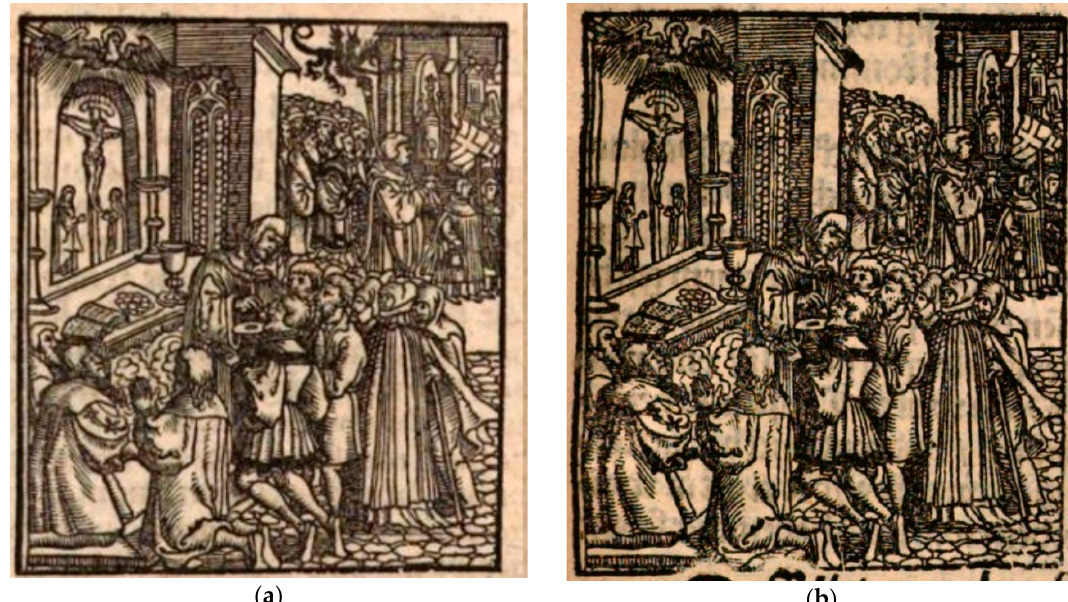
Figure 1. Communion and procession , woodcut recurring in books published by vom Berg and Neuber [S 22] (see Appendix A) ( a ) in (Luther 1544b, fol. LXXXIVv) (Munich, Bayerische Staatsbibliothek, 2 Hom. 277, urn:nbn:de:bvb:12-bsb10144039-2; NoC-NC/1.0) ( b ) in (Luther 1548, fol. CVI) (Munich, Bayerische Staatsbibliothek, 2 Hom. 281, urn:nbn:de:bvb:12-bsb10144040-5; NoC-NC/1.0).